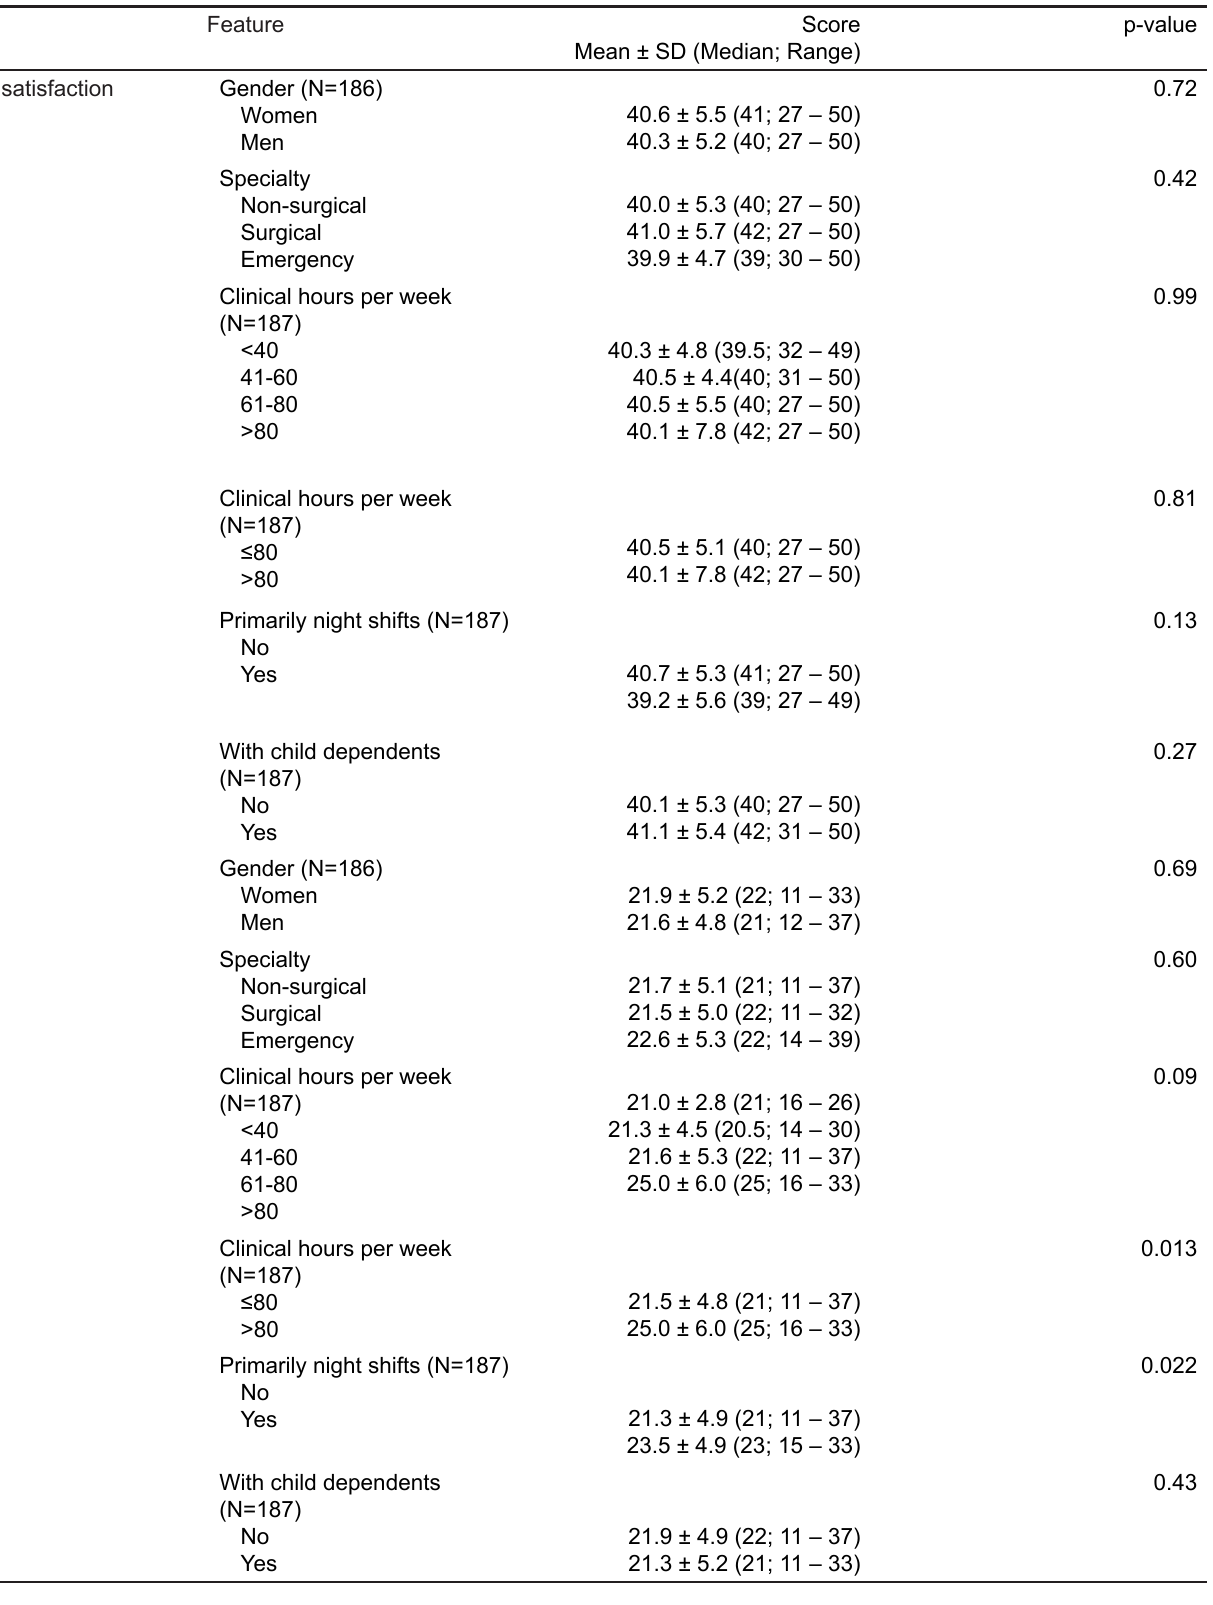
Table 2. Comparison of compassion satisfaction, burnout and secondary traumatic stress scores for 188 resident respondents according to demographic, specialty and work